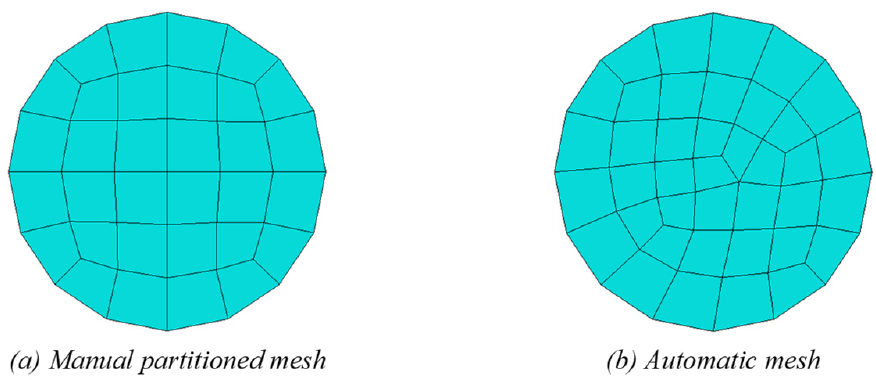
Figure 9. Cross section of steel bolt mesh optimisation.